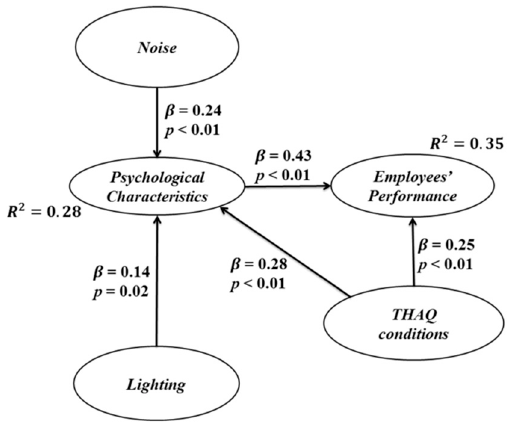
Figure 3. Significant direct effects.